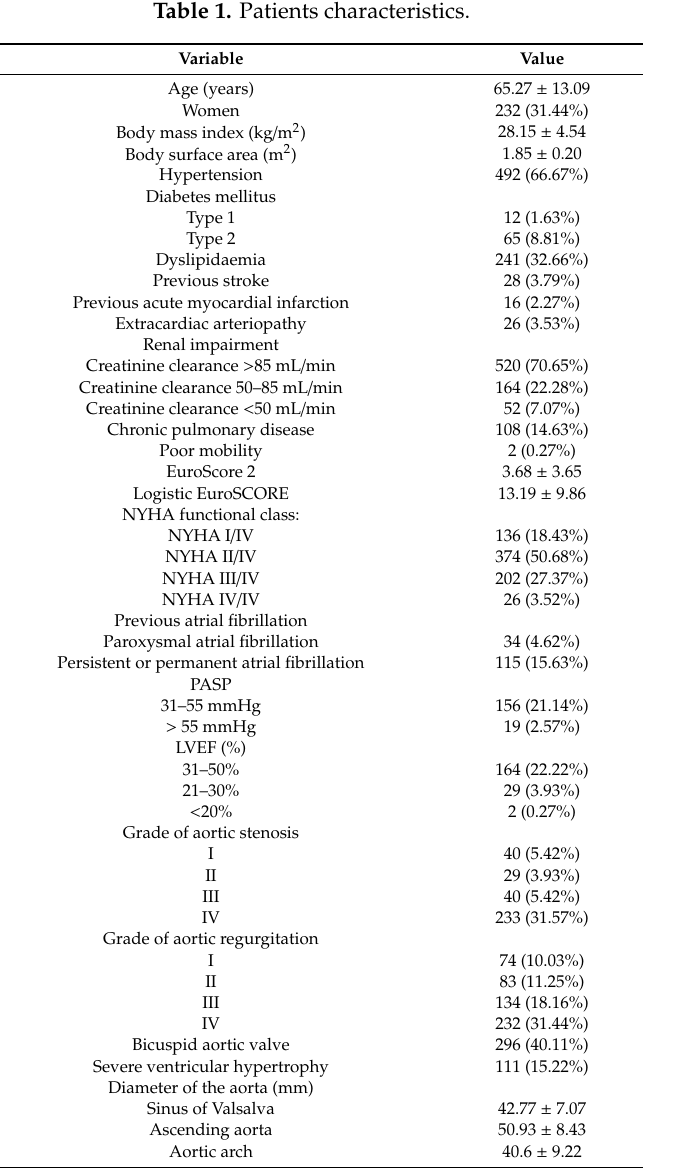
LVEF: Left ventricular ejection fraction; PASP: Pulmonary artery systolic pressure; NYHA: New York Heart